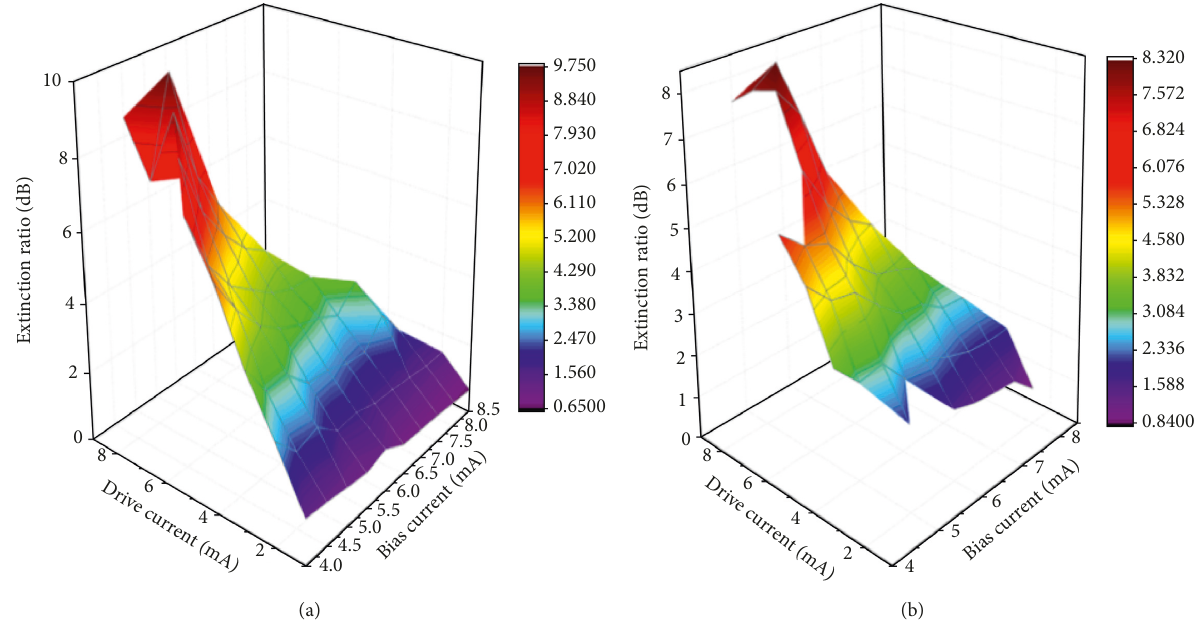
Figure 9: Extinction ratio for the laser at different bias current points as a function of drive voltage: (a) back-to-back transmission [33] and (b) 25 km